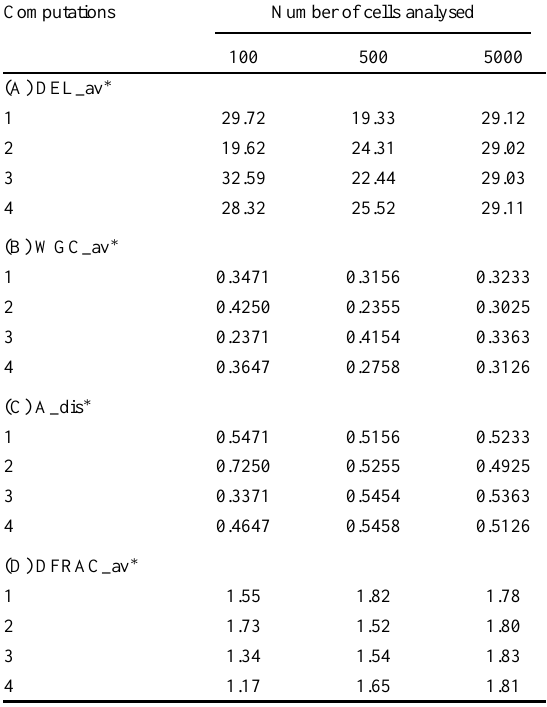
The feature values as related to the number of cells included in the analysis for the structural features DEL_av, WGC_av, A_dis, DFRAC_av, NNRR and RMPB. The CV varies between 20.2% at 100 cells analysed and 0.17% at 5000 cells analysed when the anal- ysis was performed on normal oral mucosa (Table 1). The value of 0.17 was an extreme value, that was not reproduced for the other tis- sues. However, the pattern was the same; a small number of objects included yielded a large CV (typically 15–20%), whereas a large number of cells included in the analysis yielded a CV of less than 5% in all